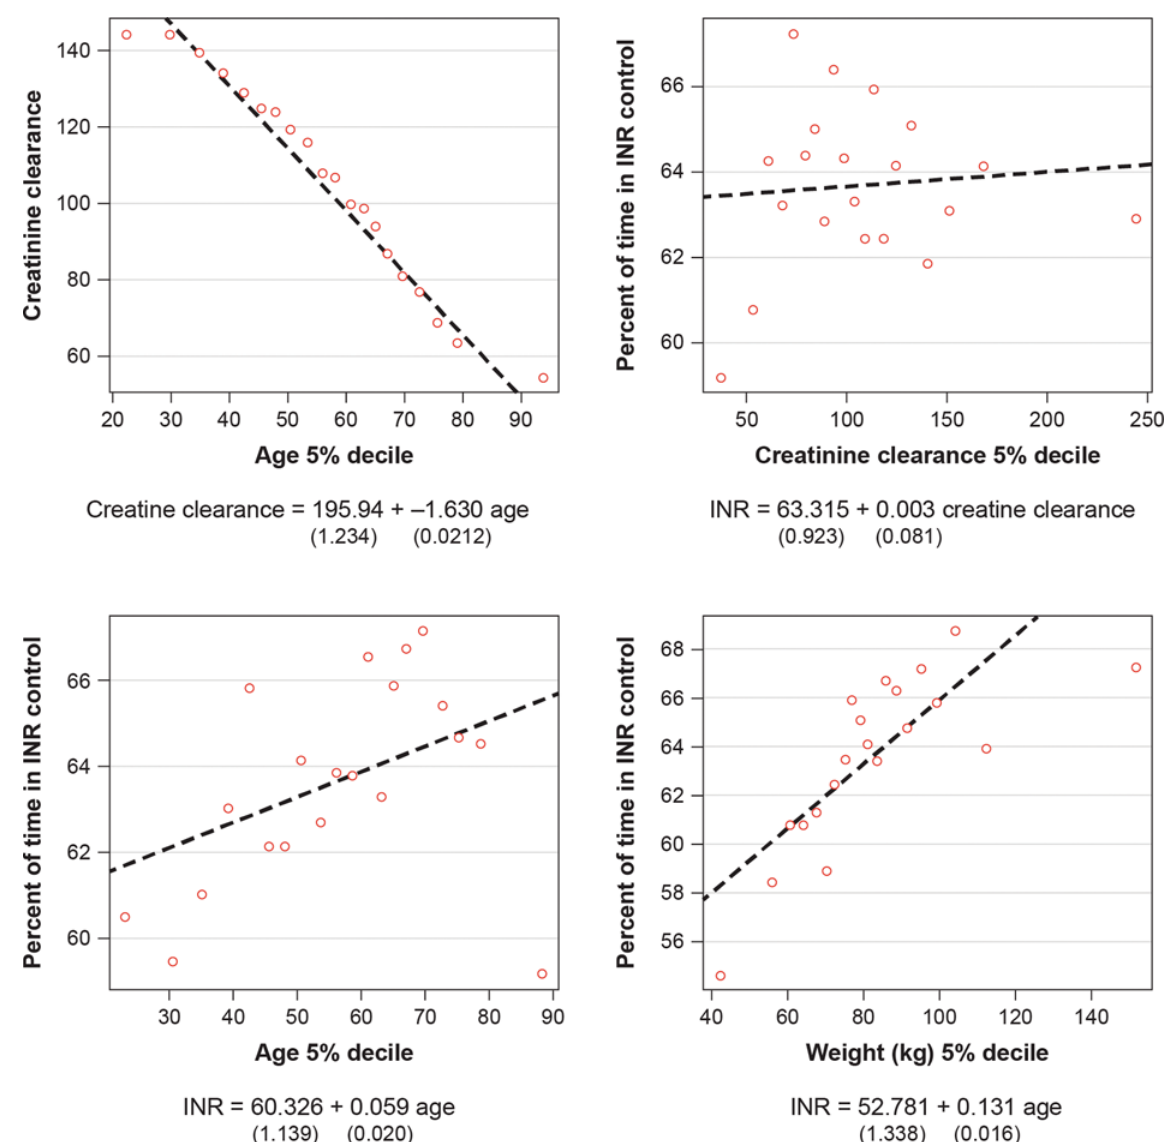
Fig. 7 relationship between age, INR control, and creatinine clearance. INR, international normalized